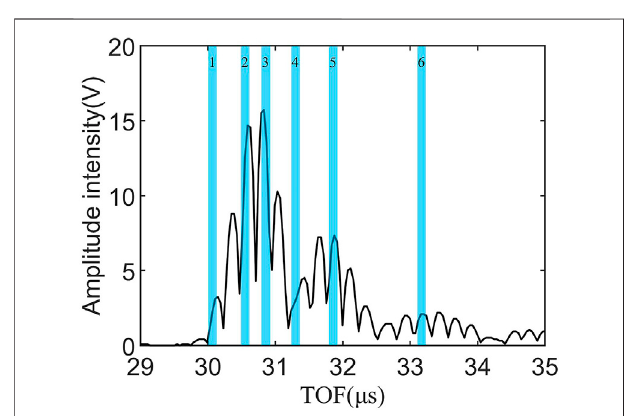
FIGURE 7 | Example of transmission waveform at the center point of battery, several intervals were selected with a small TOF gate.